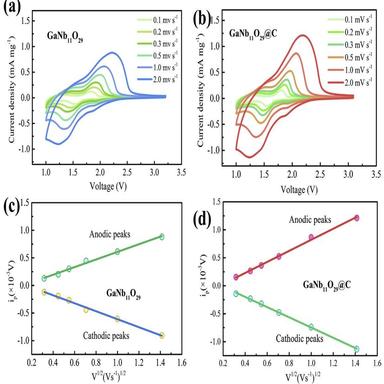
The CV curves of multiple scan rates of (a) GaNb11O29 and (b) GaNb11O29@C. The diagram of v1/2 versus ip for (c) GaNb11O29 and (d) GaNb11O29@C.